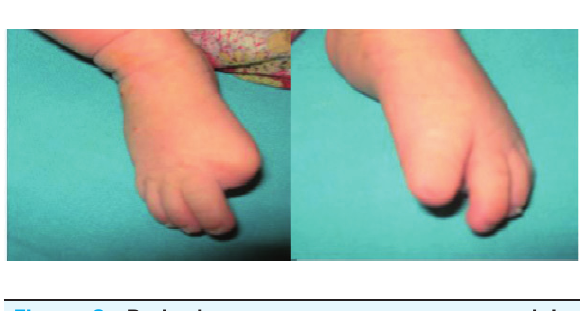
Figure 2. Both the great toes were amputated in utero. Entire right great toe was missing. The distal phalanx was missing in the left great